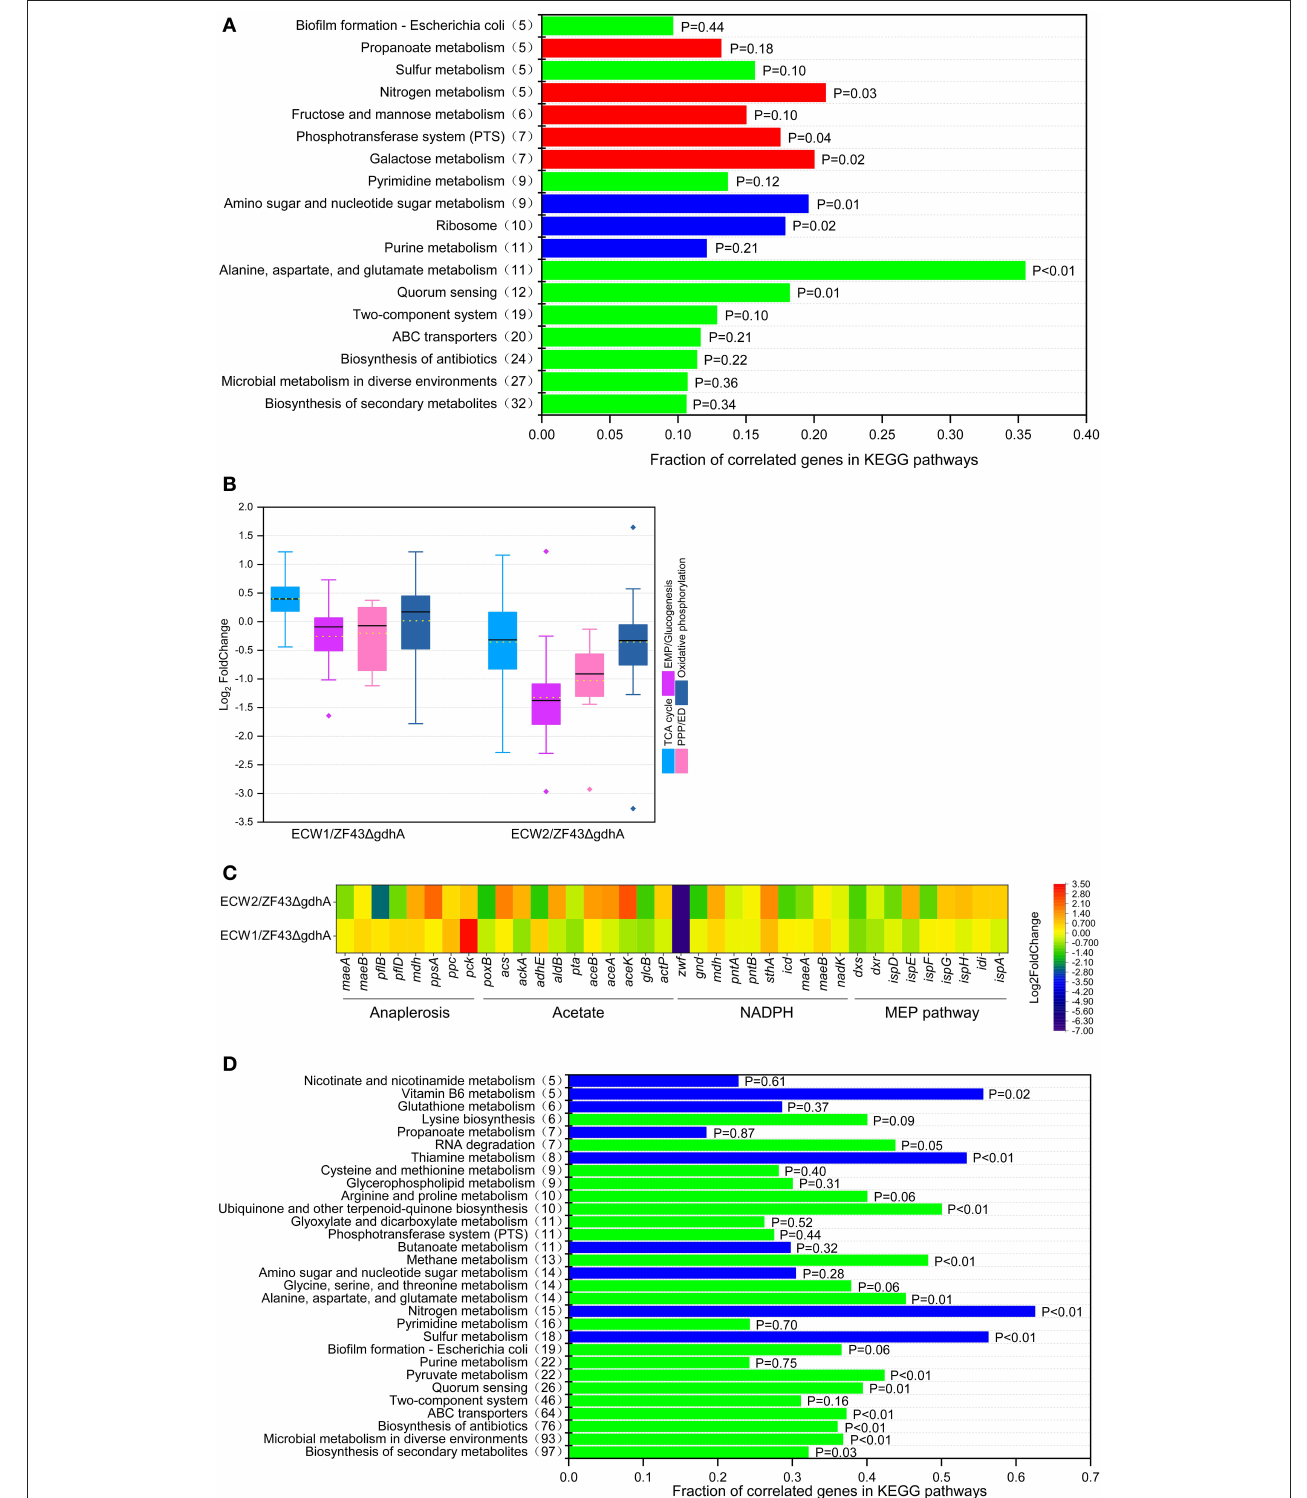
FIGURE 3 | Comparative transcriptomic analysis of Escherichia coli strains ZF43 1 gdhA , ECW1, and ECW2. (A) Fraction of correlated genes in KEGG pathways of strain ECW1 relative to those of strain ZF43 1 gdhA . The x -axis indicates the ratio of the number of genes differentially expressed in the pathway relative to the total number of genes in the pathway. The y -axis numbers in parentheses are the number of genes differentially expressed in the pathway. Red indicates an upregulated pathway, blue a downregulated pathway, and green a pathway containing both upregulated and downregulated genes. (B) Box plot of the log 2 FoldChange of the